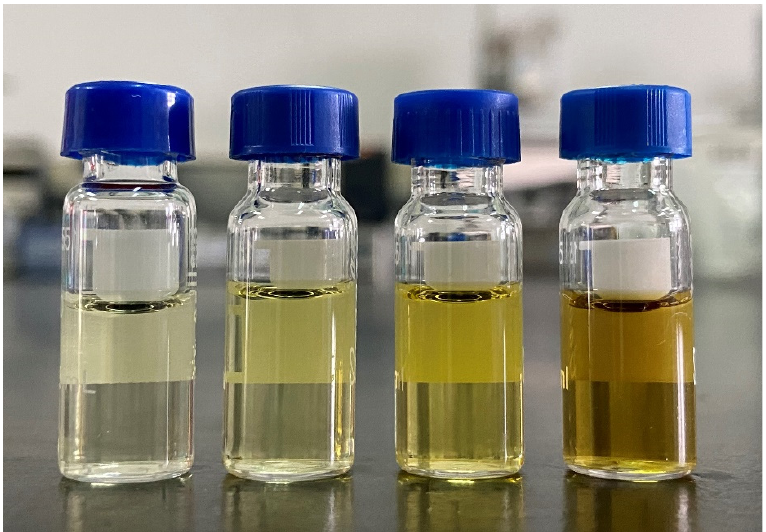
Figure 1. Comparison of color of different sorbents in hawk tea samples: from the right to the left are MgSO 4 + PSA, MgSO 4 + PSA +GCB, MgSO 4 + PSA +MWCNTs, MgSO 4 + PSA +MWCNTs + EMR-Lipid, respectively.